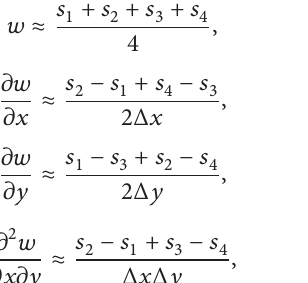
Figure 13: The experimental clamped-clamped plate.